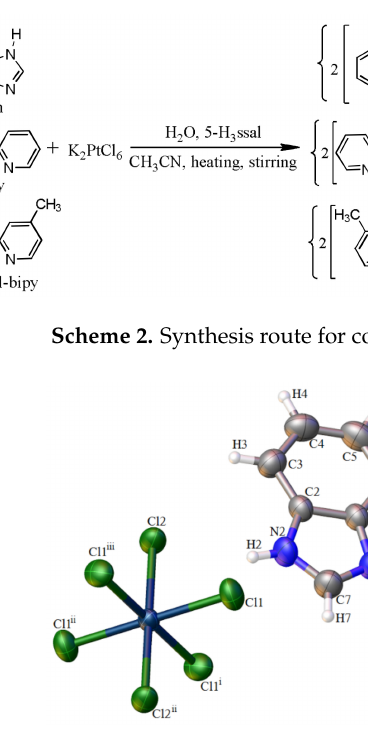
Figure 1. View of the asymmetric unit of complex 1 with the numbering scheme. The thermal probability is drawn at 30%. Symmetry codes: i = x, − y, − z; ii = − x, − y, − z; iii = − x, y, −